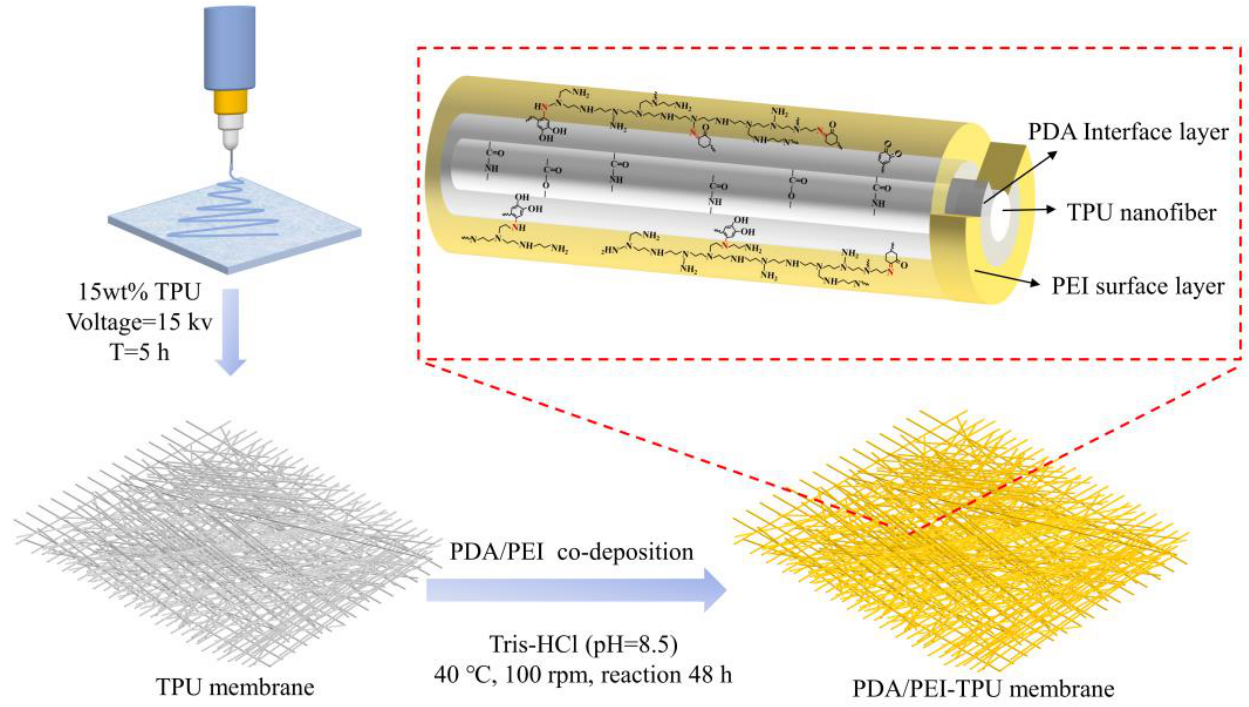
Figure 1. Schematic synthetic routes of the PDA/PEI-TPU NFMs.